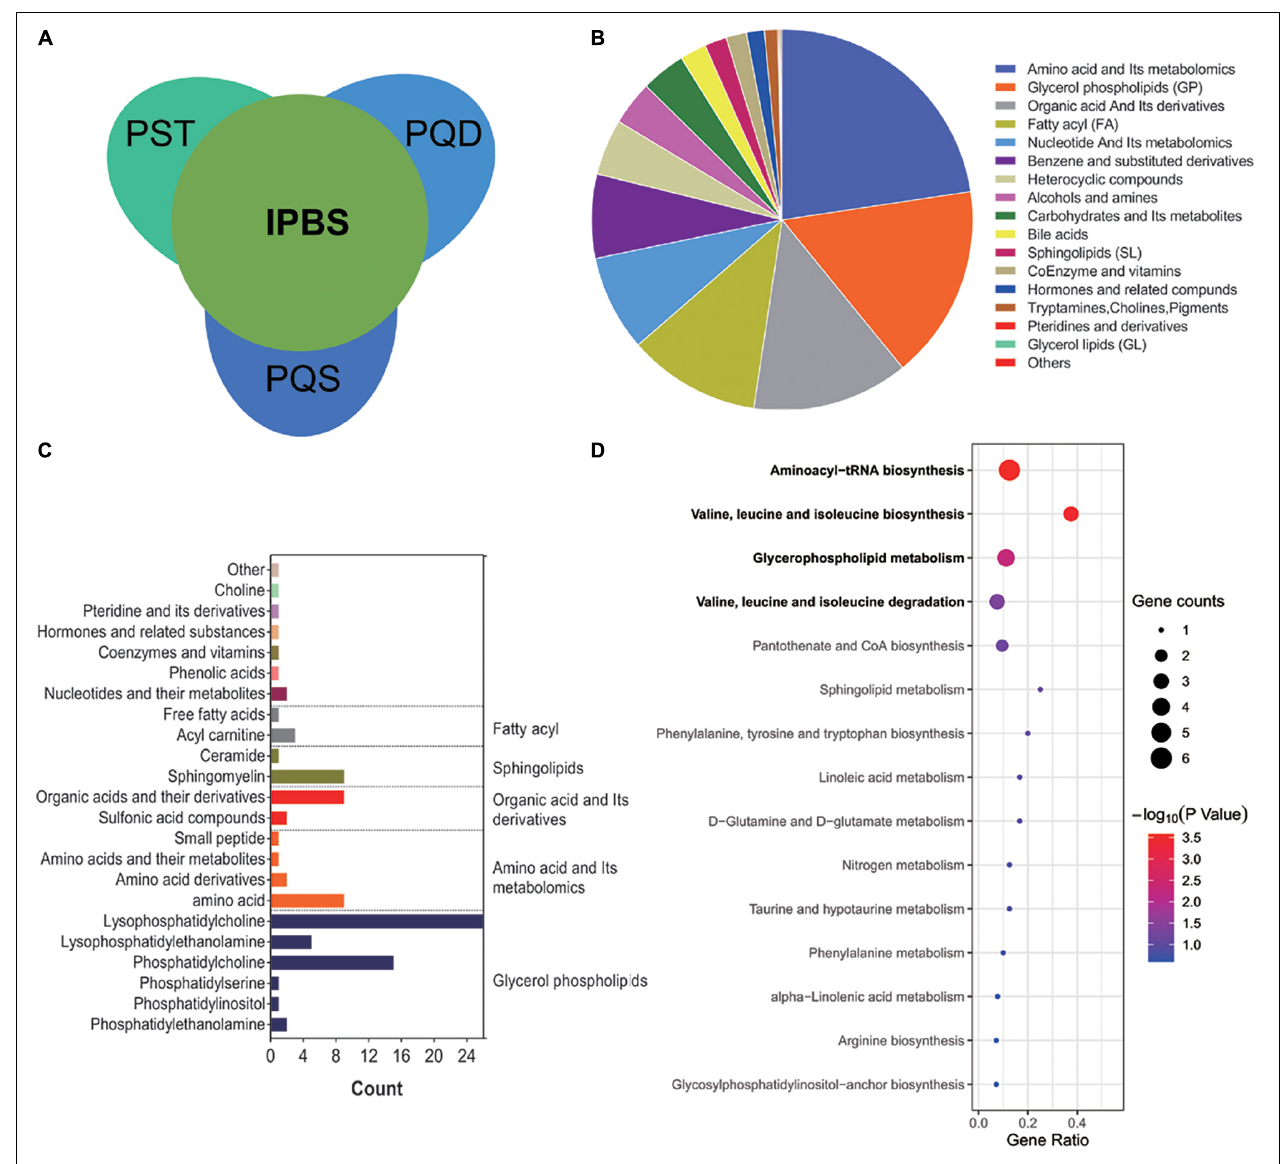
FIGURE 1 | Characteristics of metabonomics. (A) Interrelation of IPBS and its related concurrent syndromes, PST, PQD, and PQS. IPBS, intermingled phlegm and blood stasis; PST, phlegm stasis and toxin; PQD, phlegm stasis and Qi deficiency; PQS, phlegm stasis and Qi stagnation. (B) The pie chart shows the main components of 800 metabolites in the primary class. Each color represents a separate metabolite. (C) The main secondary structure of intersection among top 100 metabolites in each group. A total of 96 metabolites are included and glycerol phospholipids are the main components. (D) KEGG analysis of 96 metabolites. The gene ratio represents the enrichment factor, the bubble scale represents the number of different genes, the depth of the bubble color represents the P